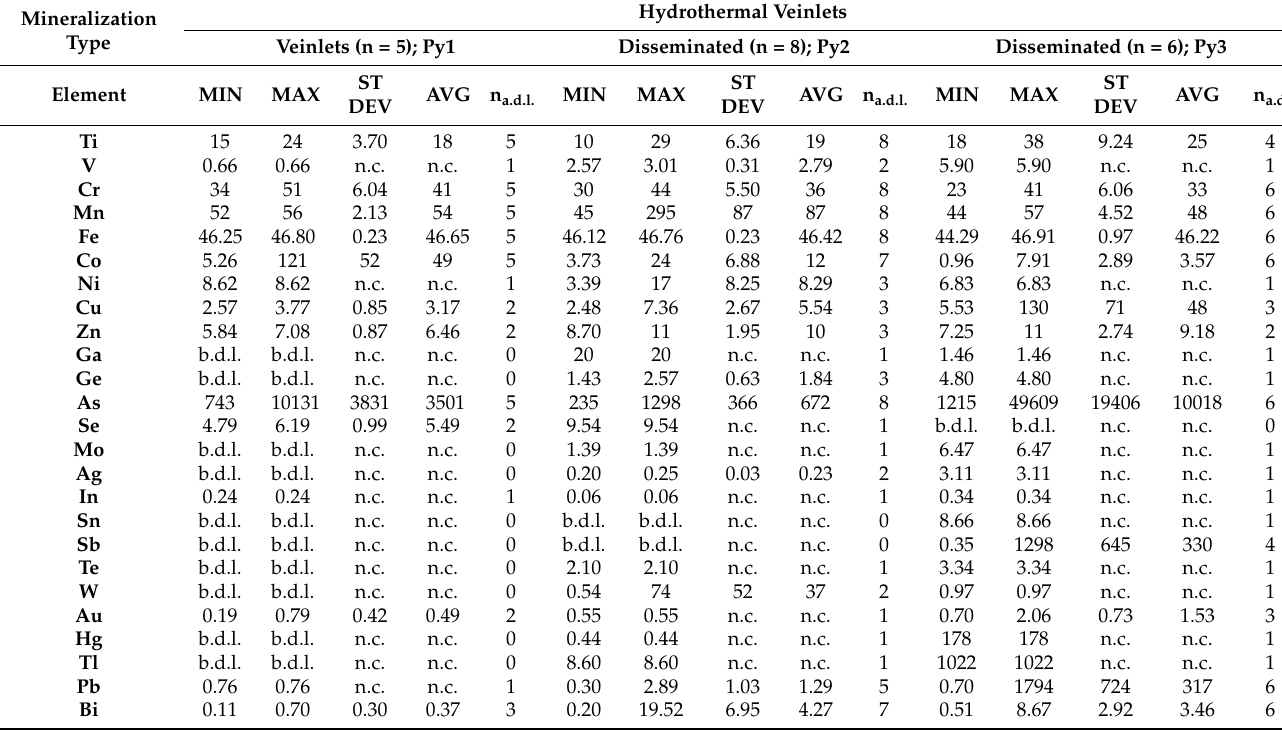
Table 3. LA-ICP-MS analyses of pyrite from Kizhnica quarry. Values are in ppm, Fe in wt. % (microprobe). Mineralization